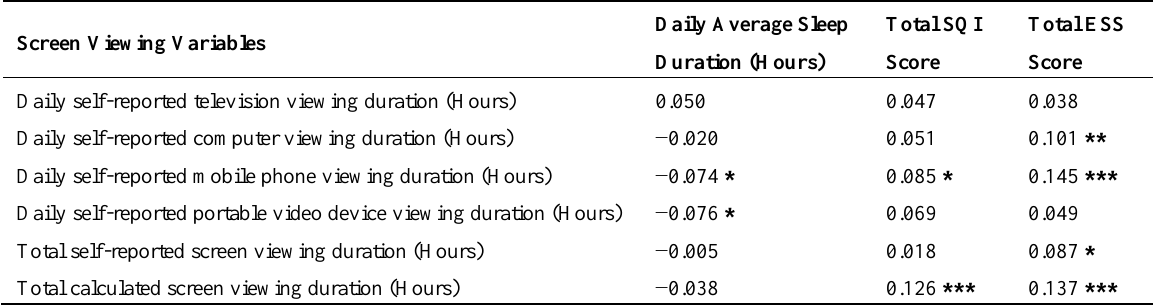
Table 4. Association between types of screen viewing and sleep duration, sleep quality, and daytime sleepiness.